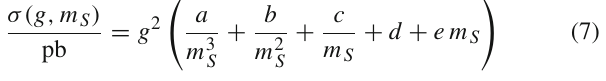
Eq. (7) at the 13 TeV LHC. The top rows are for a neutral particle, the middle rows for a positively charged and the bottom rows for a negatively charged